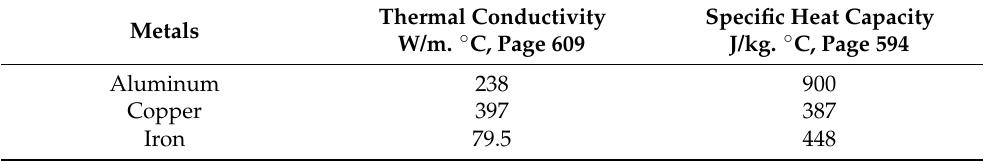
Table 1. Thermal conductivities and specific heat capacities of Al, Cu, and Fe at 25 ◦ C and 1 atm [22].